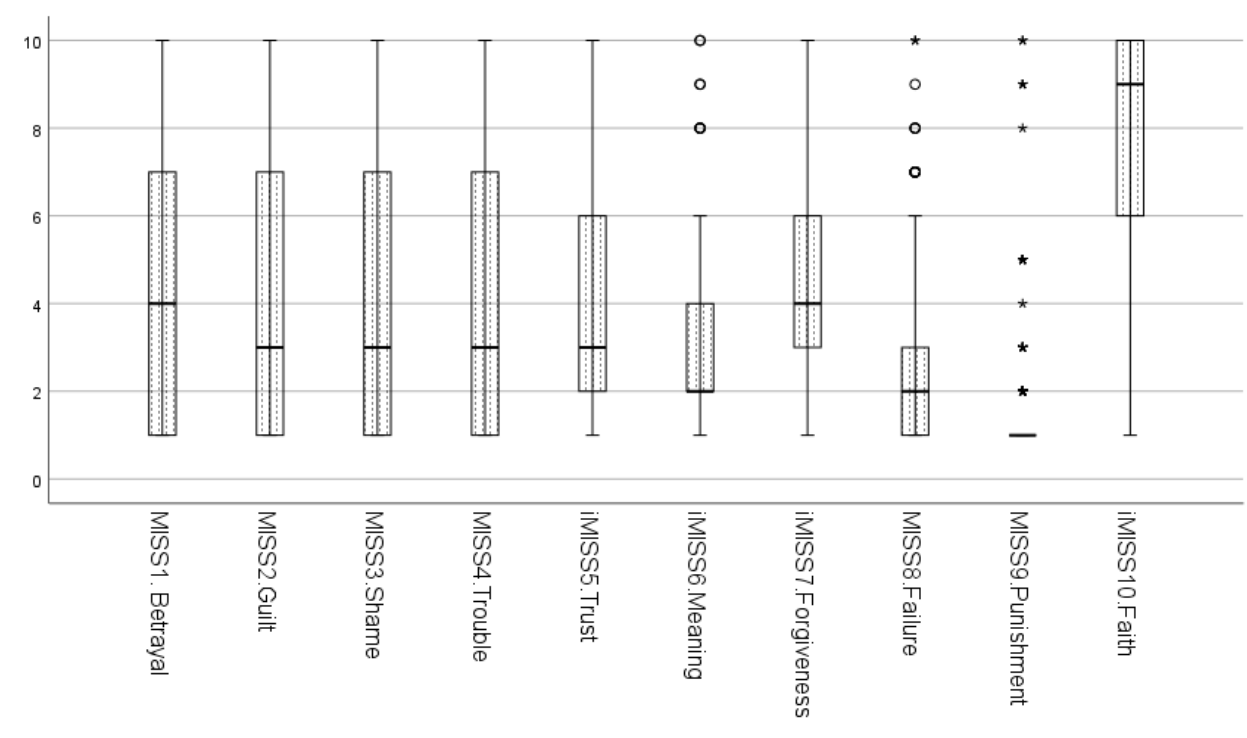
Figure 1. Boxplots of ten items of G-MISS-HP. Note. G-MISS-HP—Moral Injury Symptom Scale for Health Professionals, German version; MISS5i, MISS6i, MISS7i, MISS10i—inverted items scores due to positive wording. Table 3. G-MISS-HP interitem correlation matrix (Pearson’s correlation